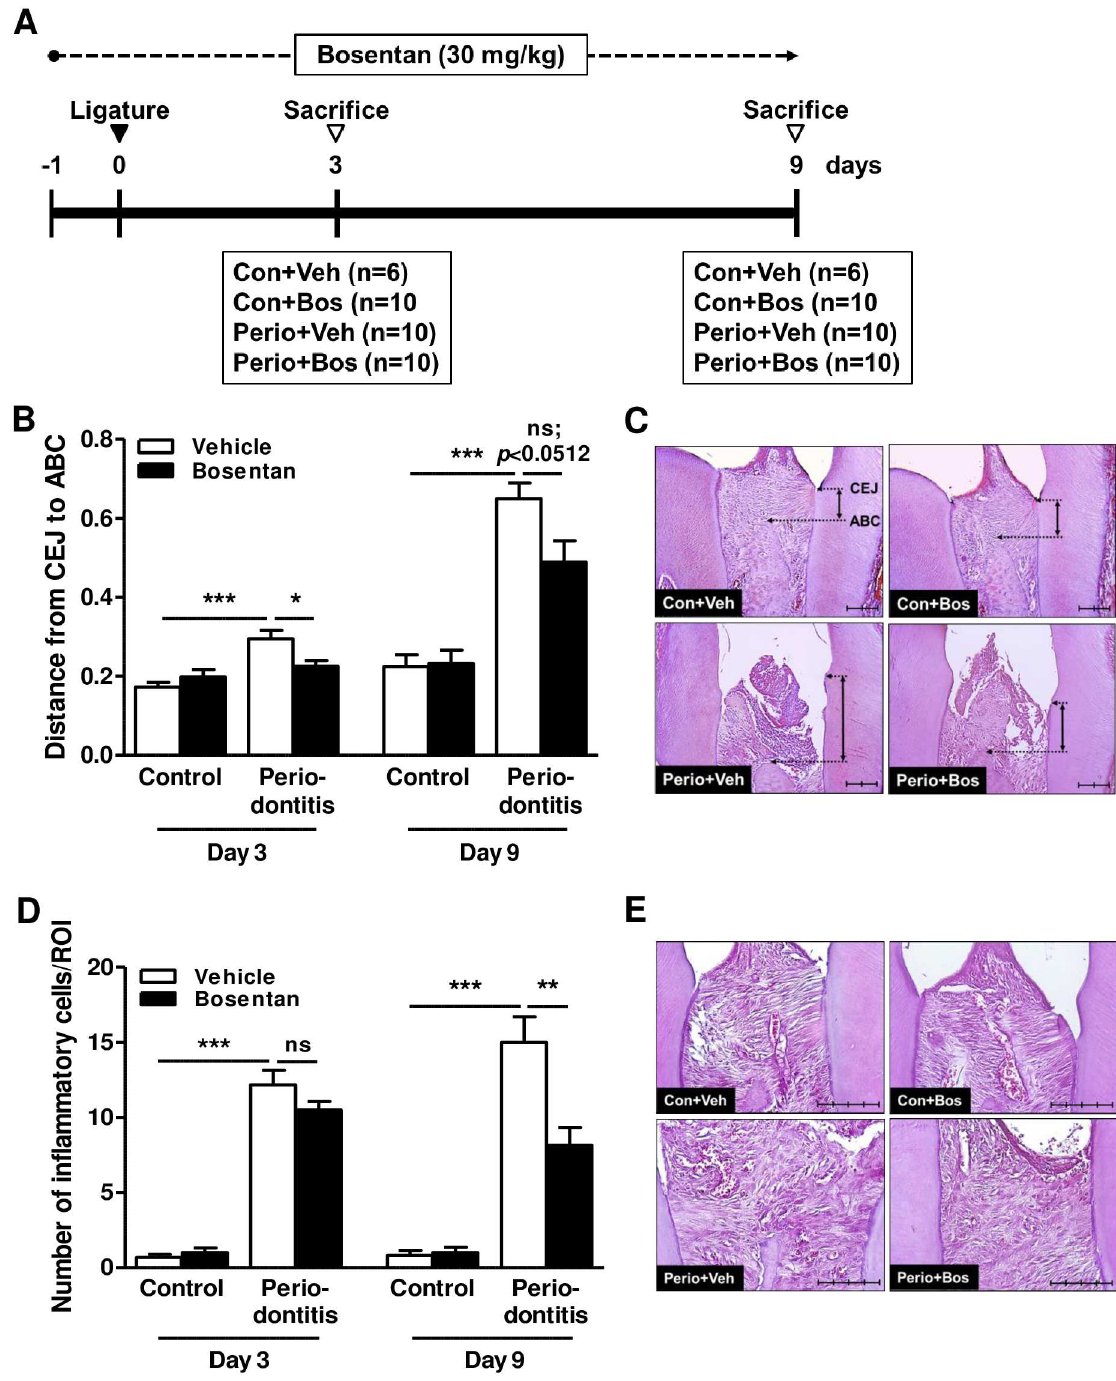
Fig 5. Effect of endothelin inhibition on ligature-induced periodontitis. (A) Experimental design and time schedule.Ligature was placedon day 0, and bosentanwas treated 1 day before ligatureligation(-1 day). On days 3 and 9 after ligatureligation,the mandibles were dissected and histomorphometric and immunohistochemicalanalyseswere performed. (B and C) Effect of endothelin inhibitionon alveolarbone loss on days 3 and 9. ABC-CEJ distances measuredby histomorphometric analysis(B) are shown alongwith representative image (C). * P < 0.05; *** P < 0.001; ns: non-significant. (D and E) Effect of endothelininhibitionon the number of inflammatory cells in the gingivaon days 3 and 9. Number of inflammatory cells (D) measuredby immunohistochemicalanalysisare shown along with the representative image (E). ** P < 0.01; *** P < 0.001. Scale bar = 100 μ m; originalmagnification × 20.